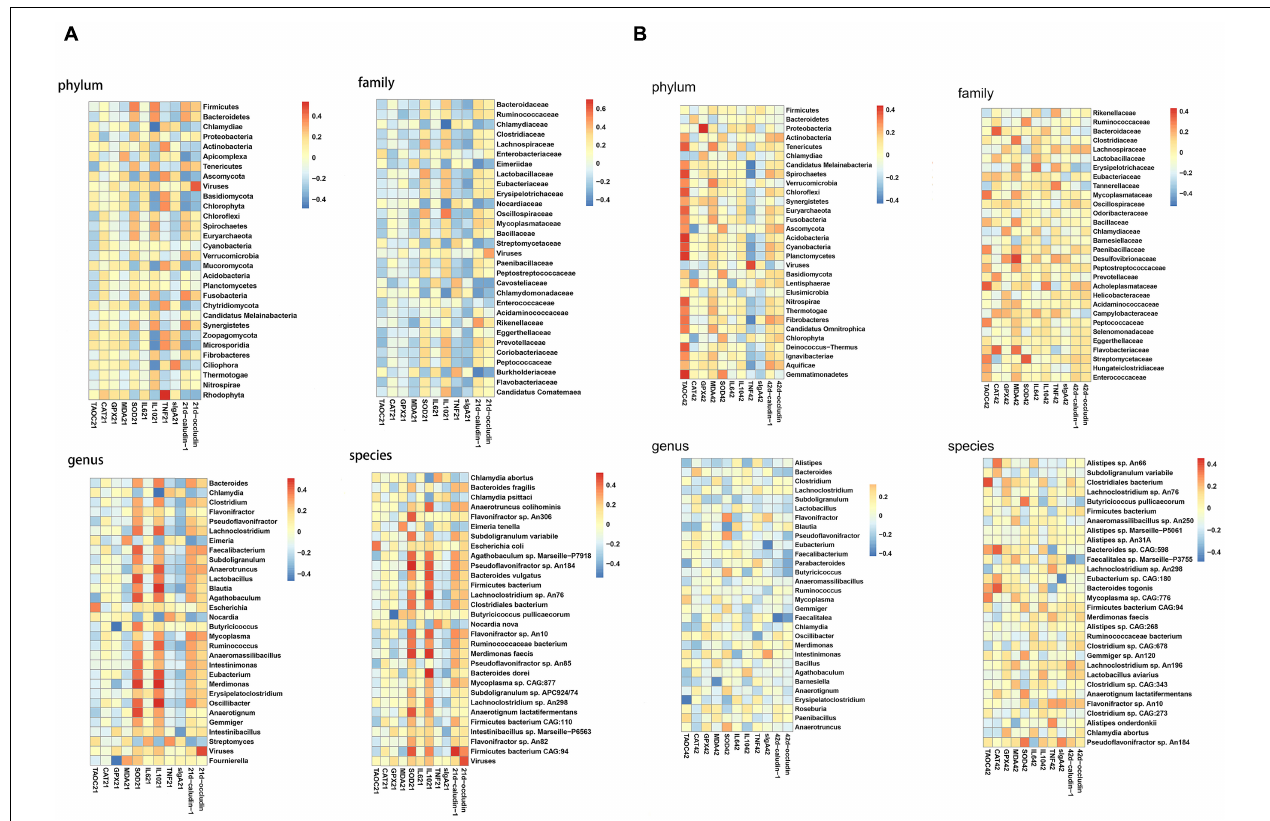
FIGURE 5 | Predicted function of metagenomic genes in the cecal contents of Eimeria -infected broilers. (A) Day 21, (B) day 42.